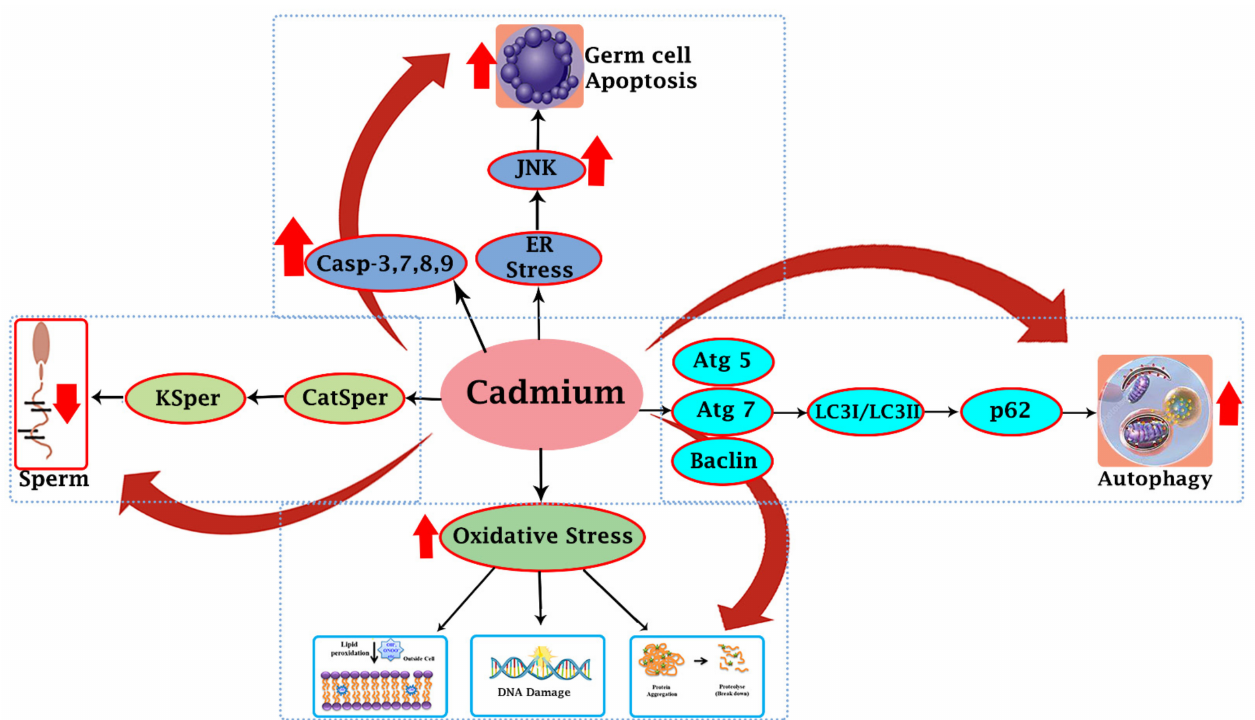
Figure 2. Potential mechanisms for cadmium-induced testicular toxicity. Up-regulation of caspase (3, 7, 8, & 9) by cadmium outcomes is testicular germ cells’ apoptosis; cadmium may also up-regulate the phosphorylation of (JNK) factors, which provoke apoptosis of germ cells through the endoplasmic reticulum stress pathway. As well as, cadmium may up-regulate the expression of autophagy-related proteins leading to high activation autophagy, which causes cell death and testicular injury. Cadmium may induce oxidative stress and cause to increase in lipid peroxidation, DNA damage, and protein damage. Cadmium may down-regulate the Ca 2+ and K + channels, and reduction in (CatSper and KSper) functioning by cadmium may lead to poor quality of